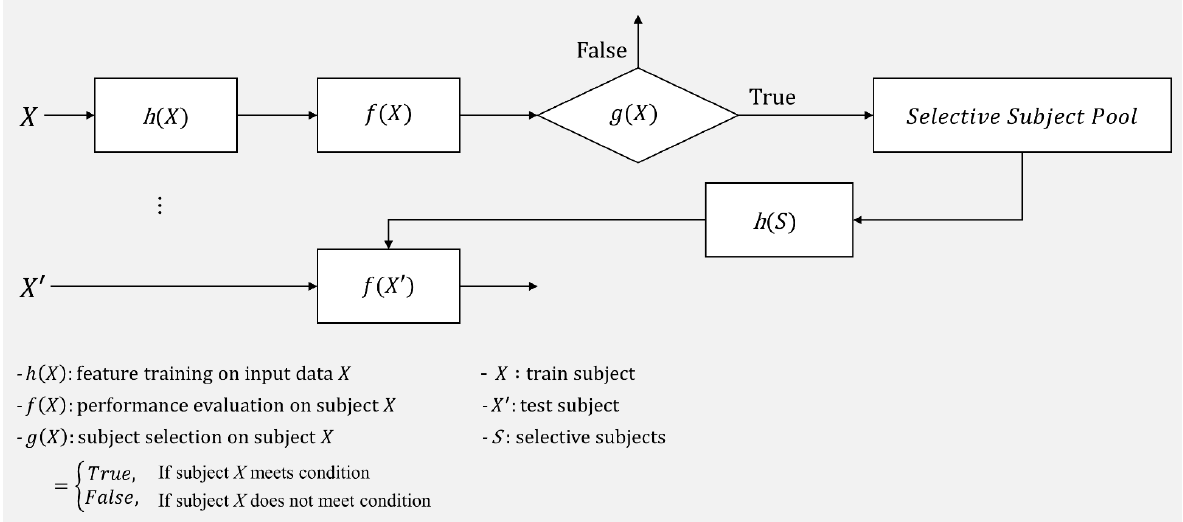
Figure 1. Selective subject pooling strategy for model generalization in motor imagery BCI. This represents the way the selective subject pooling strategy functions with h(X), f(X), and g(X). In this study, we introduce g(X) to increase the model’s ability to generalize for cross-subject/dataset evaluation f(X′) in motor imagery BCI.